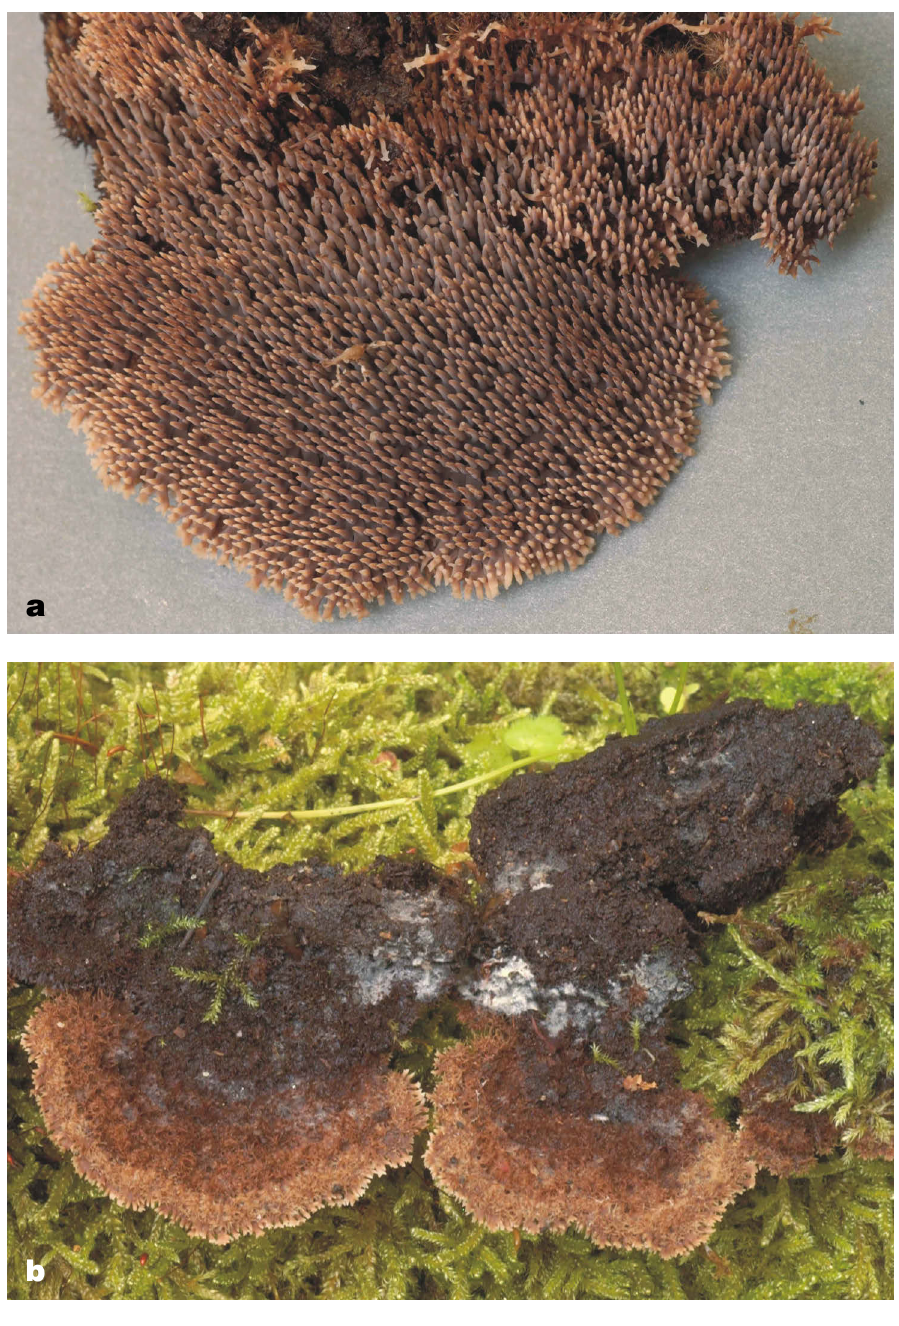
Fig. 2. Fructifications of Gloiodon strigosus : a) hymenophore with spines; b) upper surface covered with soft hairs. Phot. M.